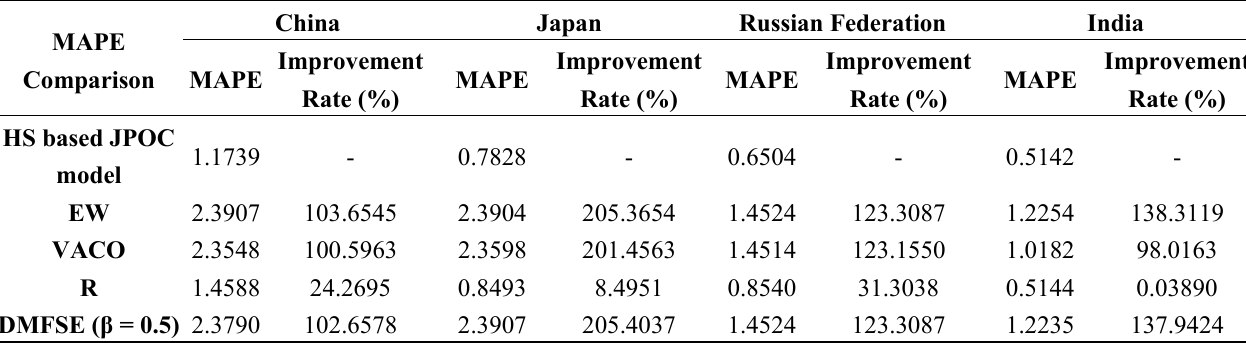
Table 12. The MAPE comparison of the HS-based JPOC model and the other combination models